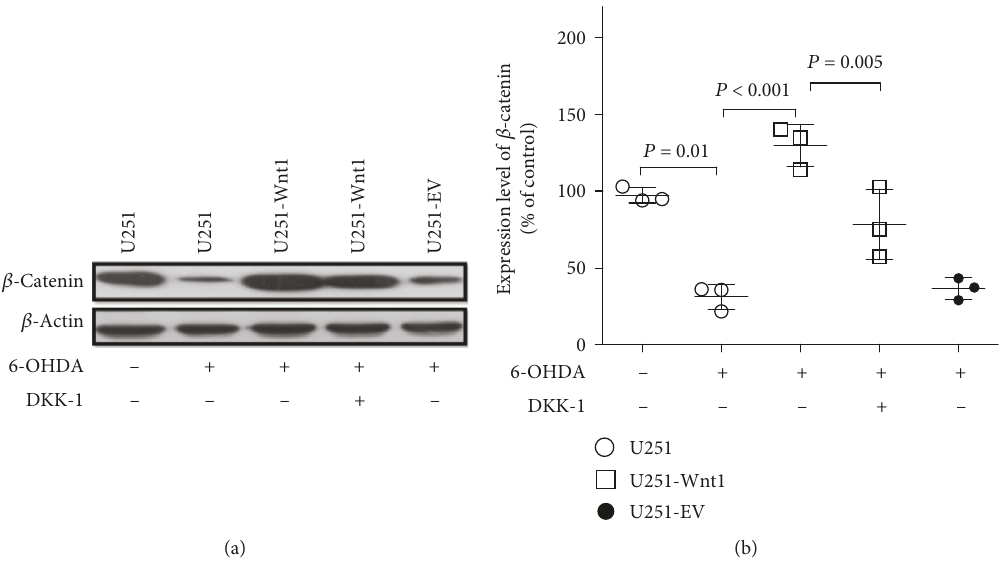
Figure 8: Wnt1 overexpression activated the Wnt/ β -catenin pathway in U251 cells. U251 cells, U251-Wnt1 cells, or U251-EV cells were treated with vehicle, 6-OHDA (50 μ M), or/and DKK-1 (100ng/ml) for 24 h, and the protein levels of β -catenin (a) were detected by Western blot with β -actin as an internal control. The relative band intensities of β -catenin (b) were measured by Quantity One software and normalized to the expression of β -actin. Di ff erences among groups were examined using ANOVA followed by using Tukey-Kramer tests for post hoc multiple comparisons. Data are presented as the mean ± SD of 3 experiments. F value = 30.23, df = 4 , df = 10 , and df = 14 betweengroups withingroups total